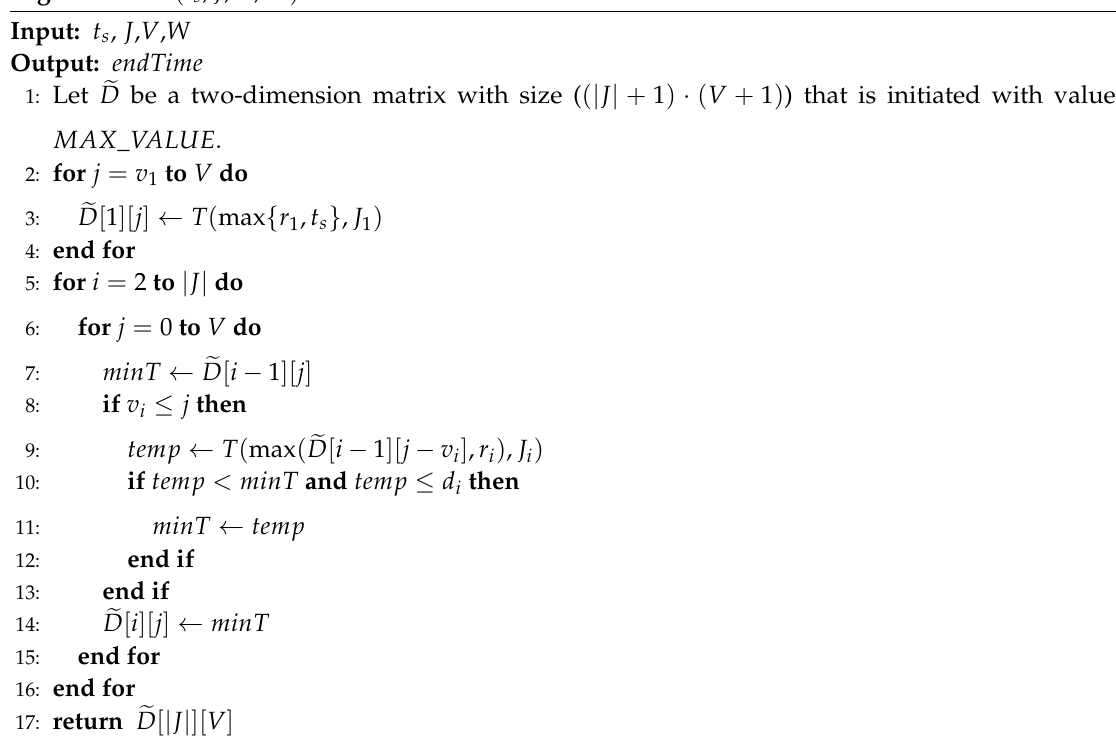
Algorithm 2 D ( t s , J , V , W )